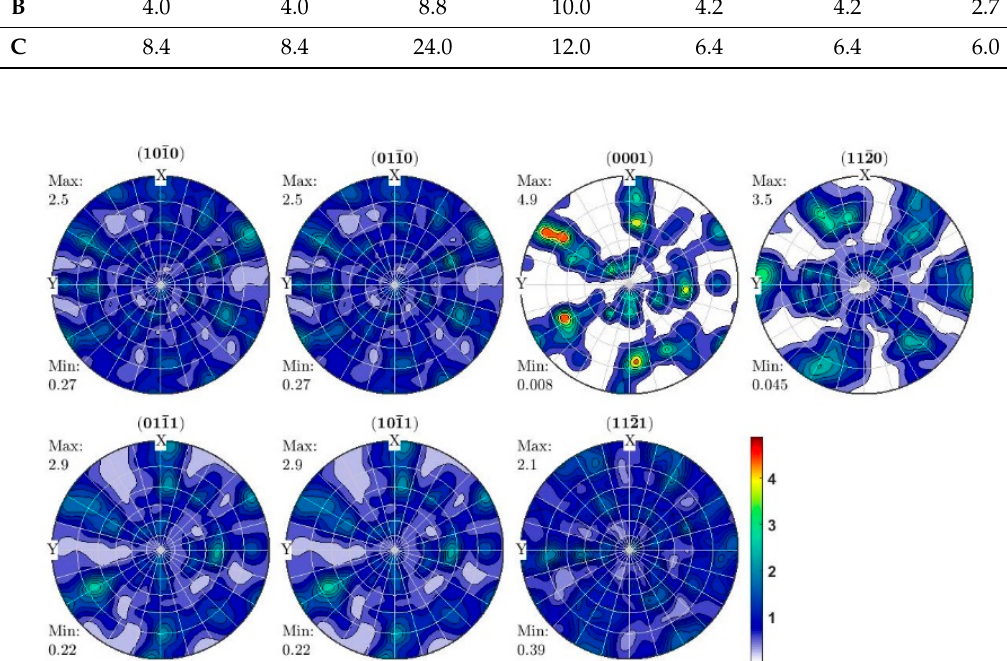
(cid:16) (cid:17) (cid:16) (cid:17) (cid:16) (cid:17) (cid:16) (cid:17) 1120 , 0111 , 1011 and 1121 PFs of the α -phase for samples